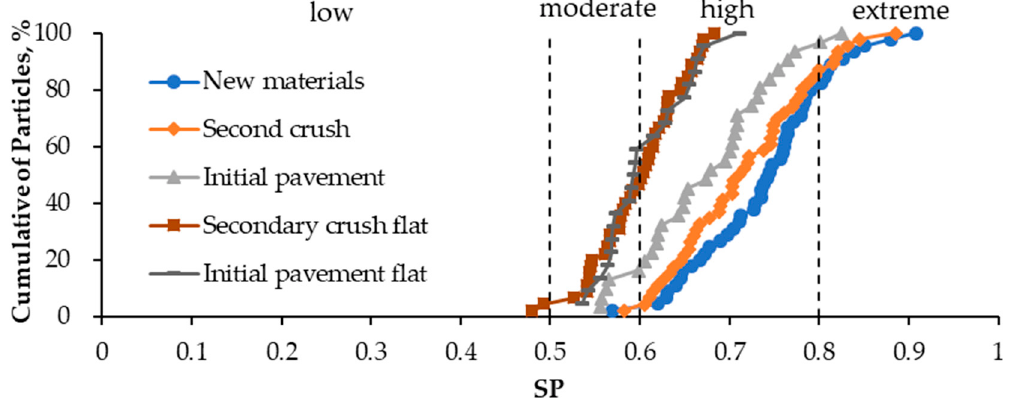
Figure 15. Comparison of Sphericity between new and RAP materials.